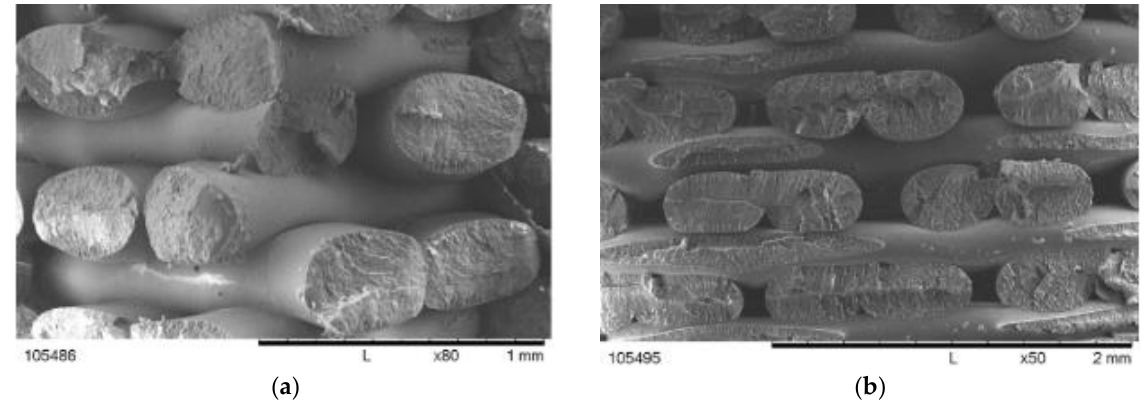
Figure 10. Fracture surface of ( a ) −45 °/45° and ( b ) 0°/90° ABS specimens after failure under tensile fatigue load (Adapted with permission from [24]. Copyright 2019, Elsevier).